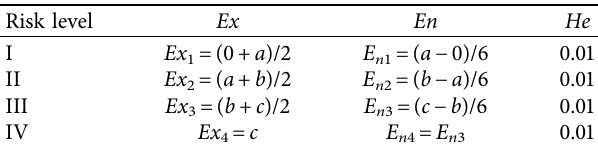
Table 6: Calculation rules for cloud numerical characteristic of quantitative